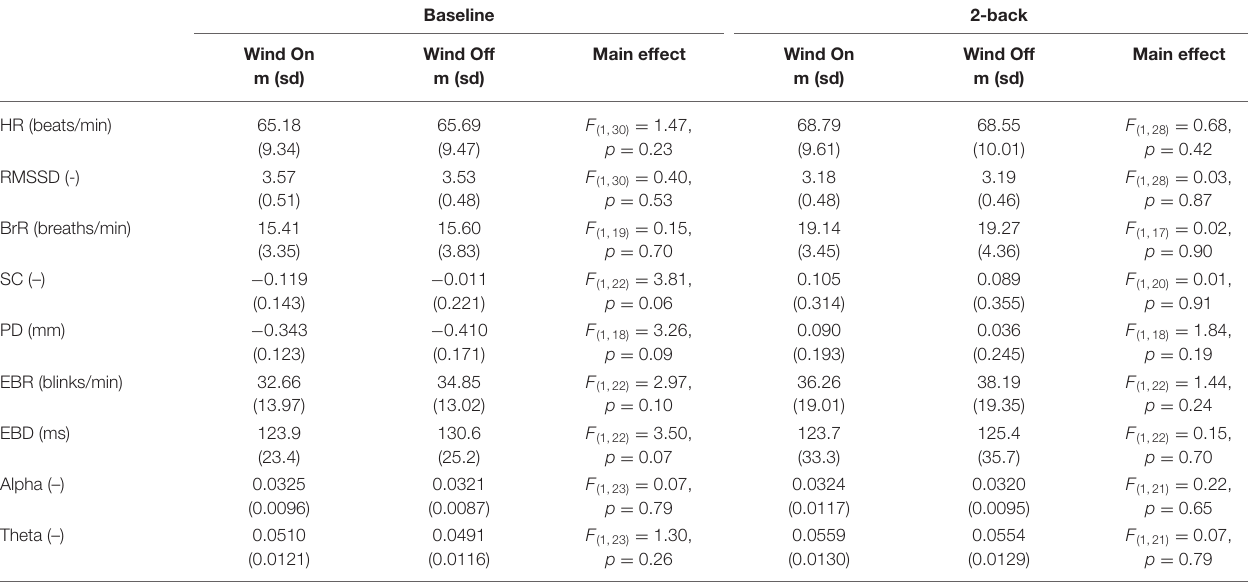
TABLE 1 | Effects of crosswinds on each physiological measure and task